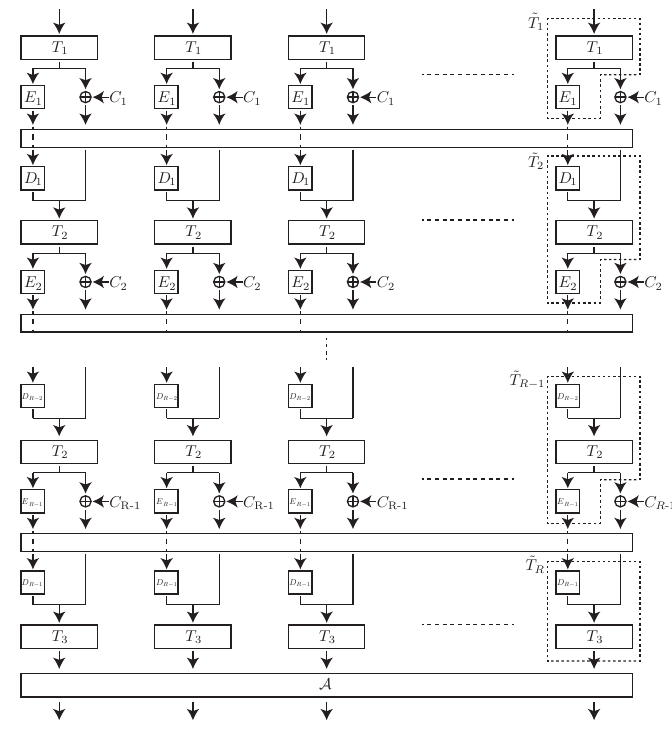
Figure 3: Canonical representation of encryption algorithm of Yoroi